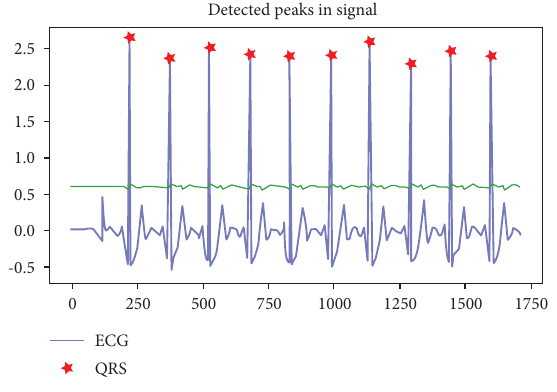
Figure 10: R peaks detection.